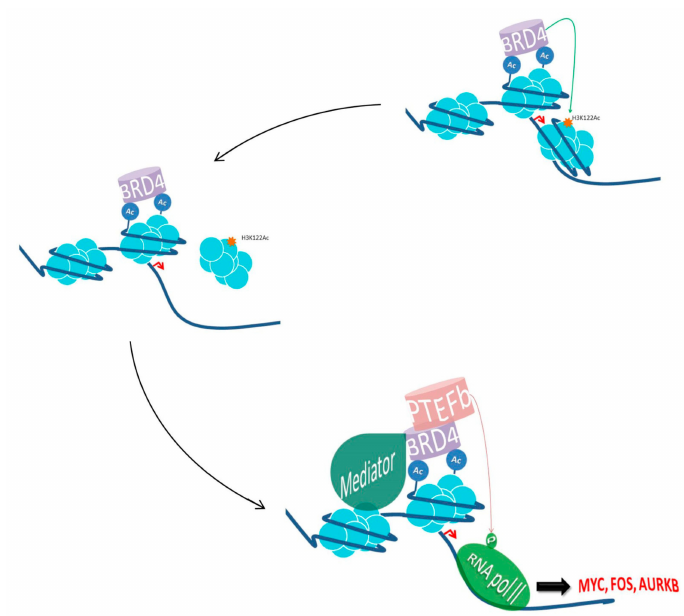
Figure 1. Schematic representation of BRD4 transcriptional activation. BRD4 acetylates histone tail lysines (Ac), and eventually H3K122, leading to nucleosome clearance and the recruitment of Mediator complex favoring and stabilizing the binding of RNA-PolII. BRD4 also interacts and activates P-TEFb, stimulating RNA-PolII to promote transcriptional activation of factors involved in cell cycle control and proliferation such as Aurora B, Cyclin D, E2F, MYC, FOSL1, TCF4 and